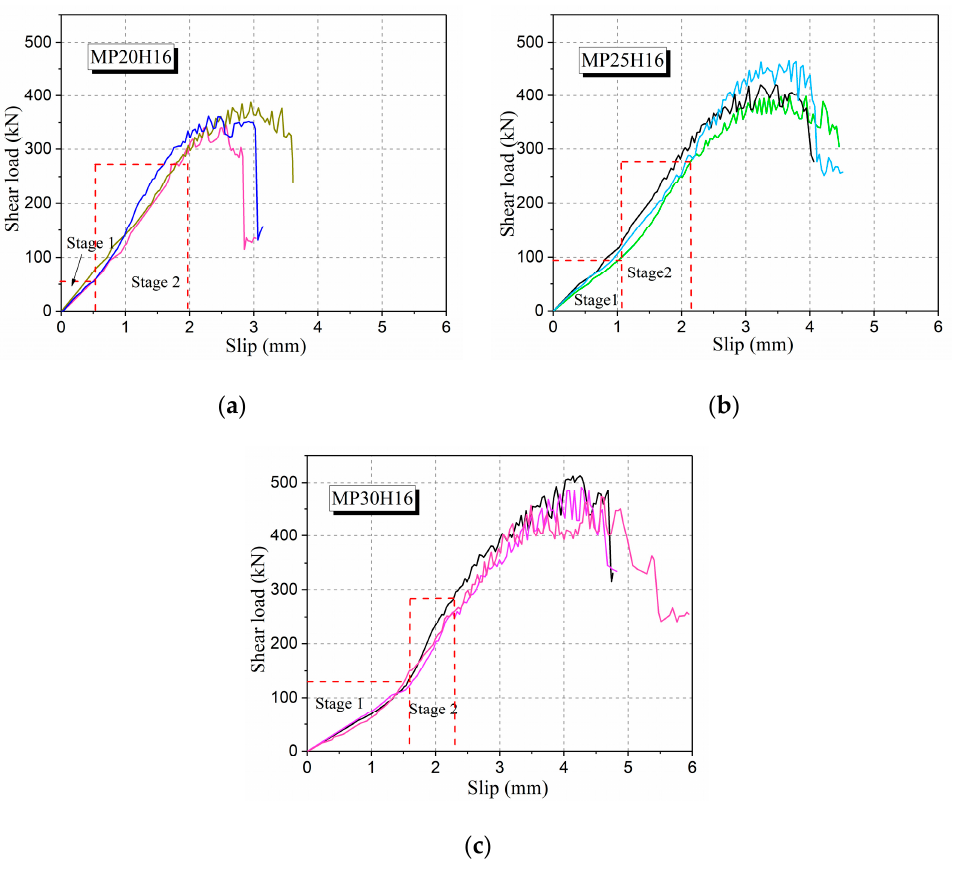
Figure 11. Shear load–slip curves of UHPC specimens with a different fiber volume fraction: ( a ) MP20H16, ( b ) MP25H16 and ( c )